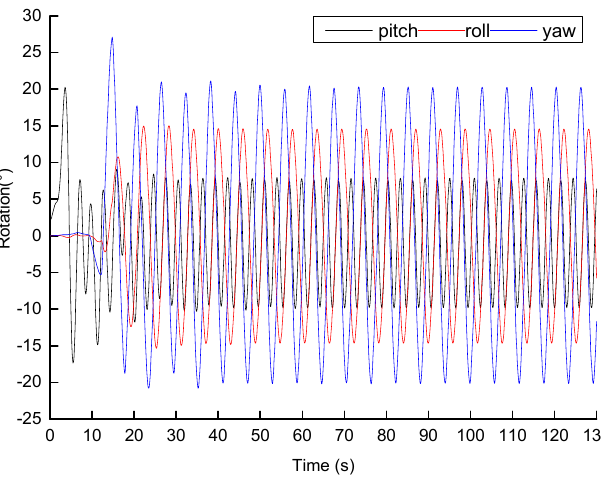
Figure 10. The angle variations of the pitch, roll, and yaw in scheme 1. The angle variations of the pitch, roll, and yaw in scheme 2 are shown in Figure 11. The pitch varies by approximately ±4°, the roll varies by ±13°, and the yaw varies by ±5°. The pitch angles vary slightly, which will help the device embrace head-on waves and absorb their energy. The angles of scheme 2 in the RX, RY, and RZ directions benefit the stable floating of the device, making scheme 2 the optimal choice.